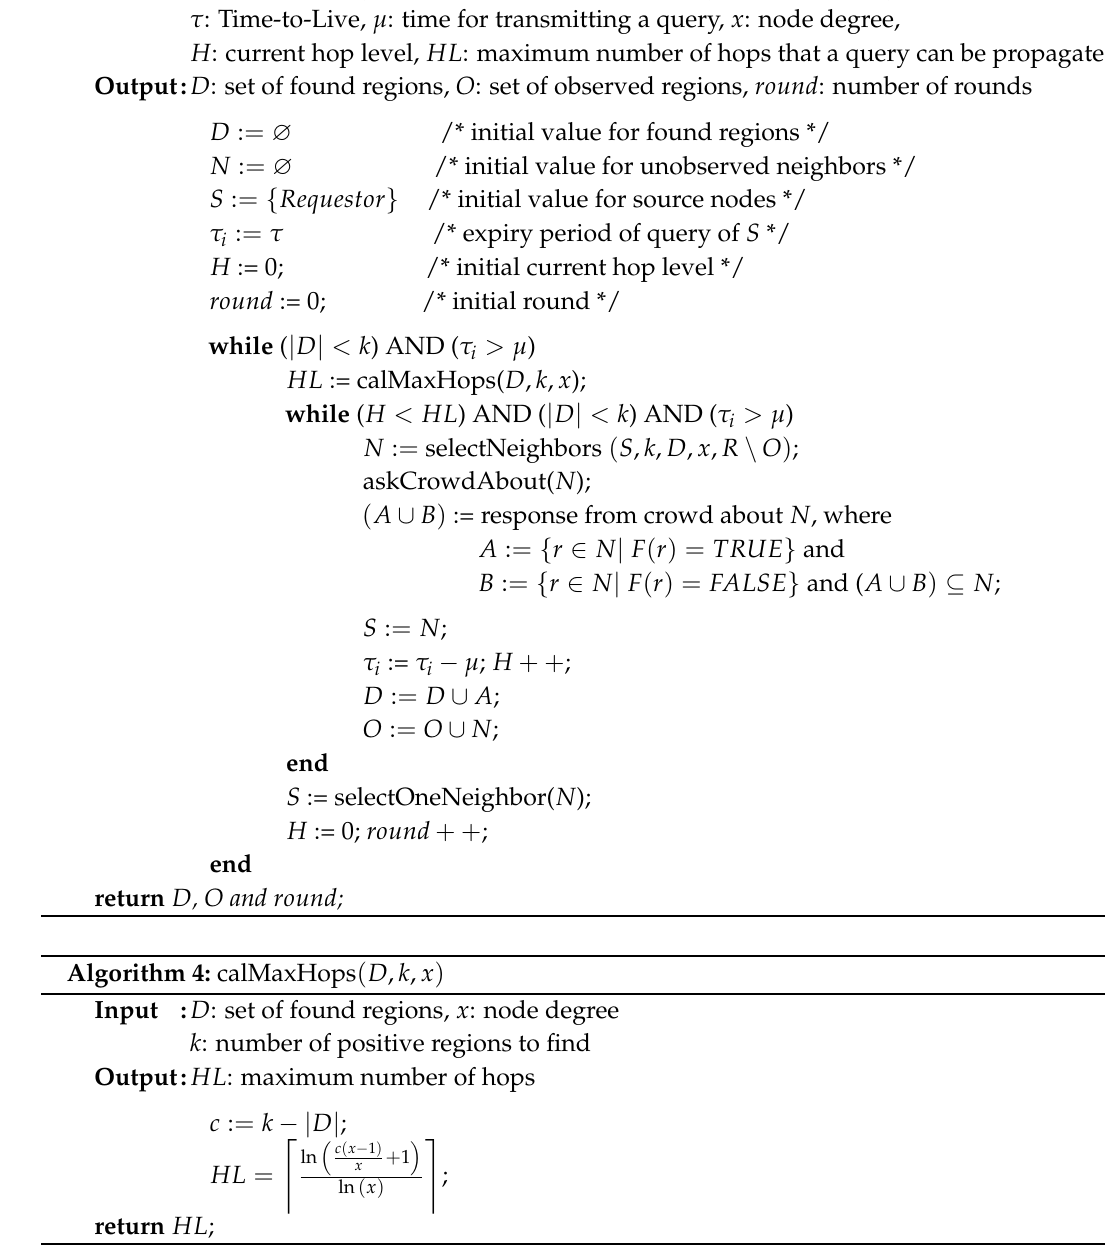
Algorithm 5: selectOneNeighbor ( N